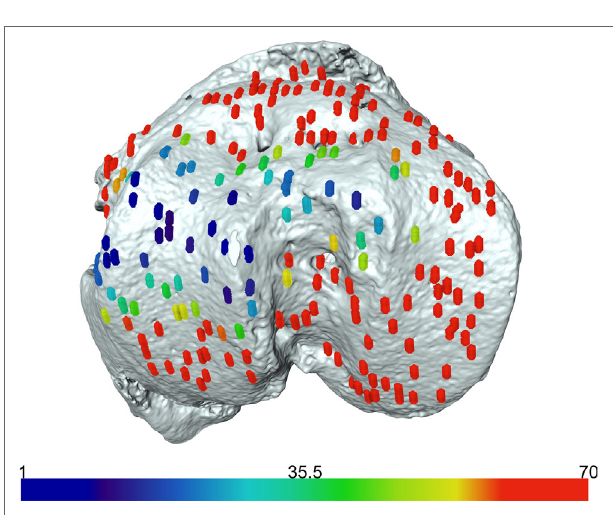
FigUre 4 | Laboratory-based computed tomography image of the tibial joint surface from a 20-month-old C57BL6 female mouse. The distribution of the areal number density of bridges is superimposed on the tibial joint surface and each bridge has a color that represents the areal number density at the bridge